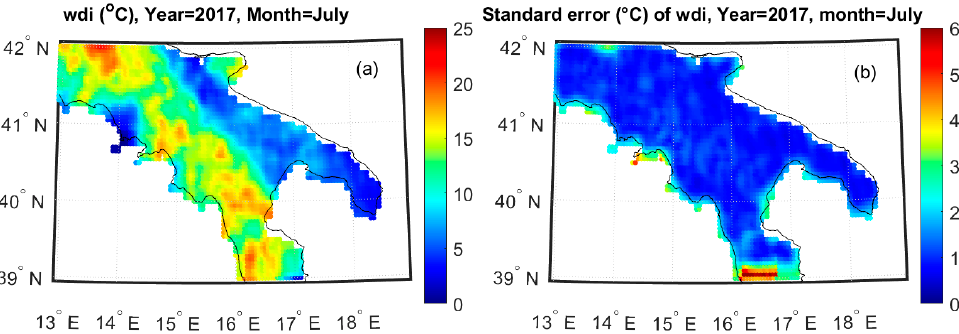
Figure 5. Level 3 map at a grid step of 0.05 ◦ for the index wdi obtained from the source data shown in Figure 3 (panel ( a )) and its standard deviation (panel ( b )). The map is exemplified for July 2017.